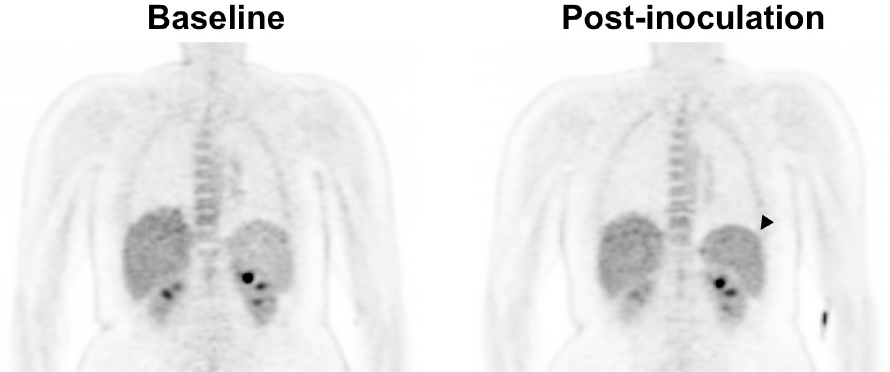
Fig 3. Baseline and postinoculation PET imaging in Participant 1 ( P . vivax group). Increased radiotracer uptake is evident in the spleen on postinoculation imaging (arrowhead). PET, positron emission